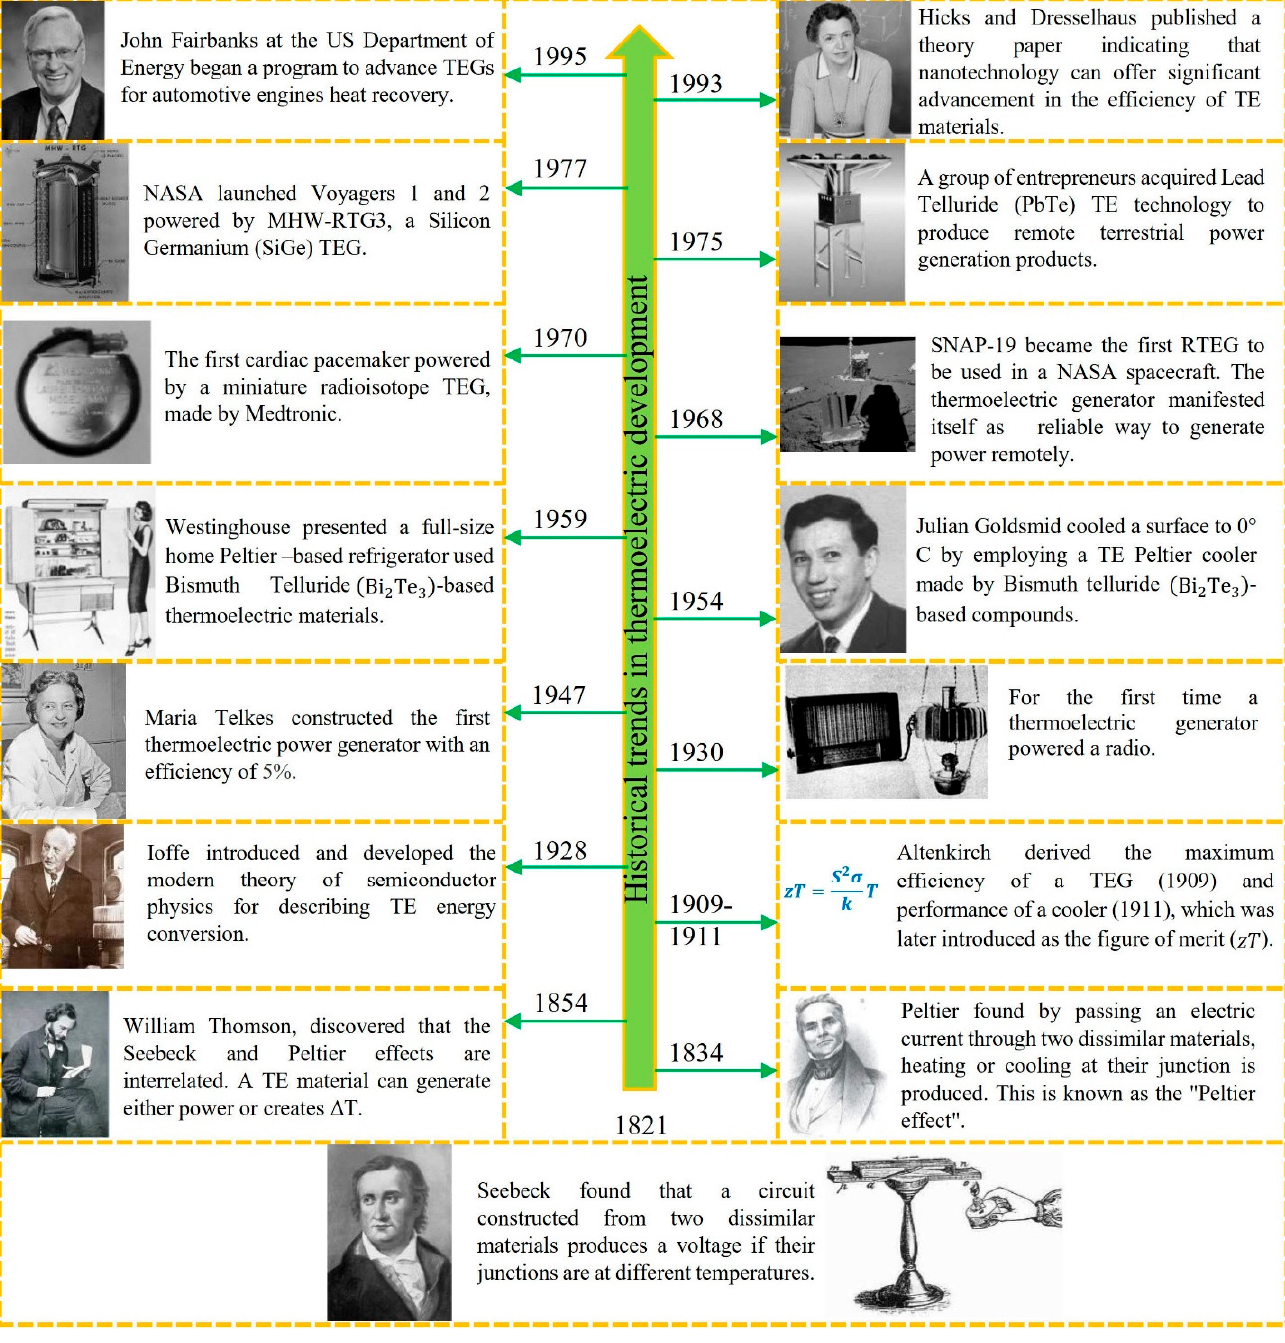
Figure 5. Historical trends in thermoelectric development [13–15].